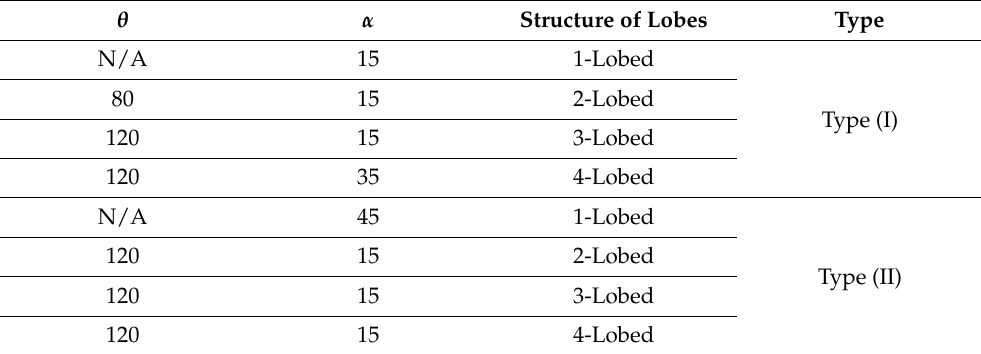
Table 3. Optimized value for angles of α and θ